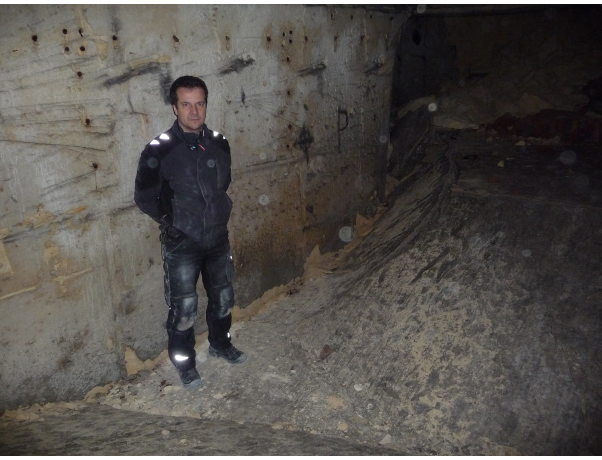
Figure 8. The strongly tilted mine floor in the collapse area of the